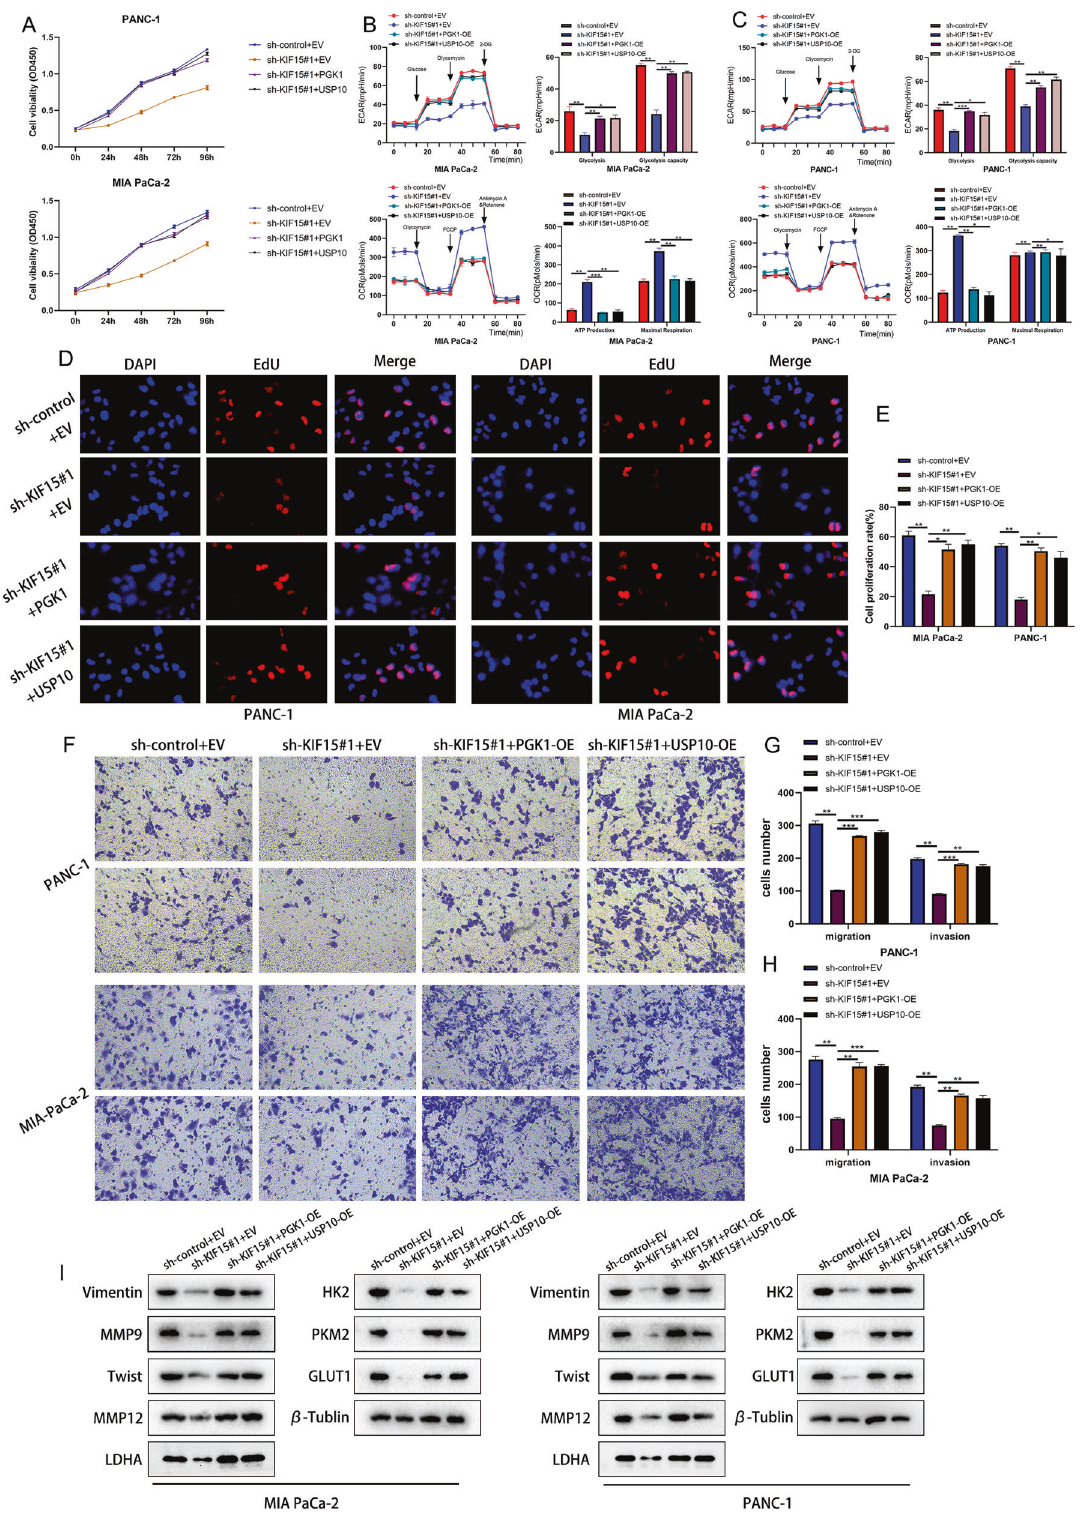
Fig. 7 USP10 and PGK1 were essential for KIF15 to mediate the malignant phenotype of PC. A The proliferation rate of PC cells measured by CCK-8 assay. B The ECAR assay and quanti fi cation of PC cells transfected with indicated plasmids. C The OCR assay and quanti fi cation of PC cells transfected with indicated plasmids. D The EdU assay of PC cells transfected with indicated plasmids. E The quanti fi cation of EdU assay. F The Transwell experiment of PC cells transfected with indicated plasmids. G , H The quanti fi cation of Transwell assay. I The western blot assay of glycolysis, proliferation and invasion markers in PC cells.